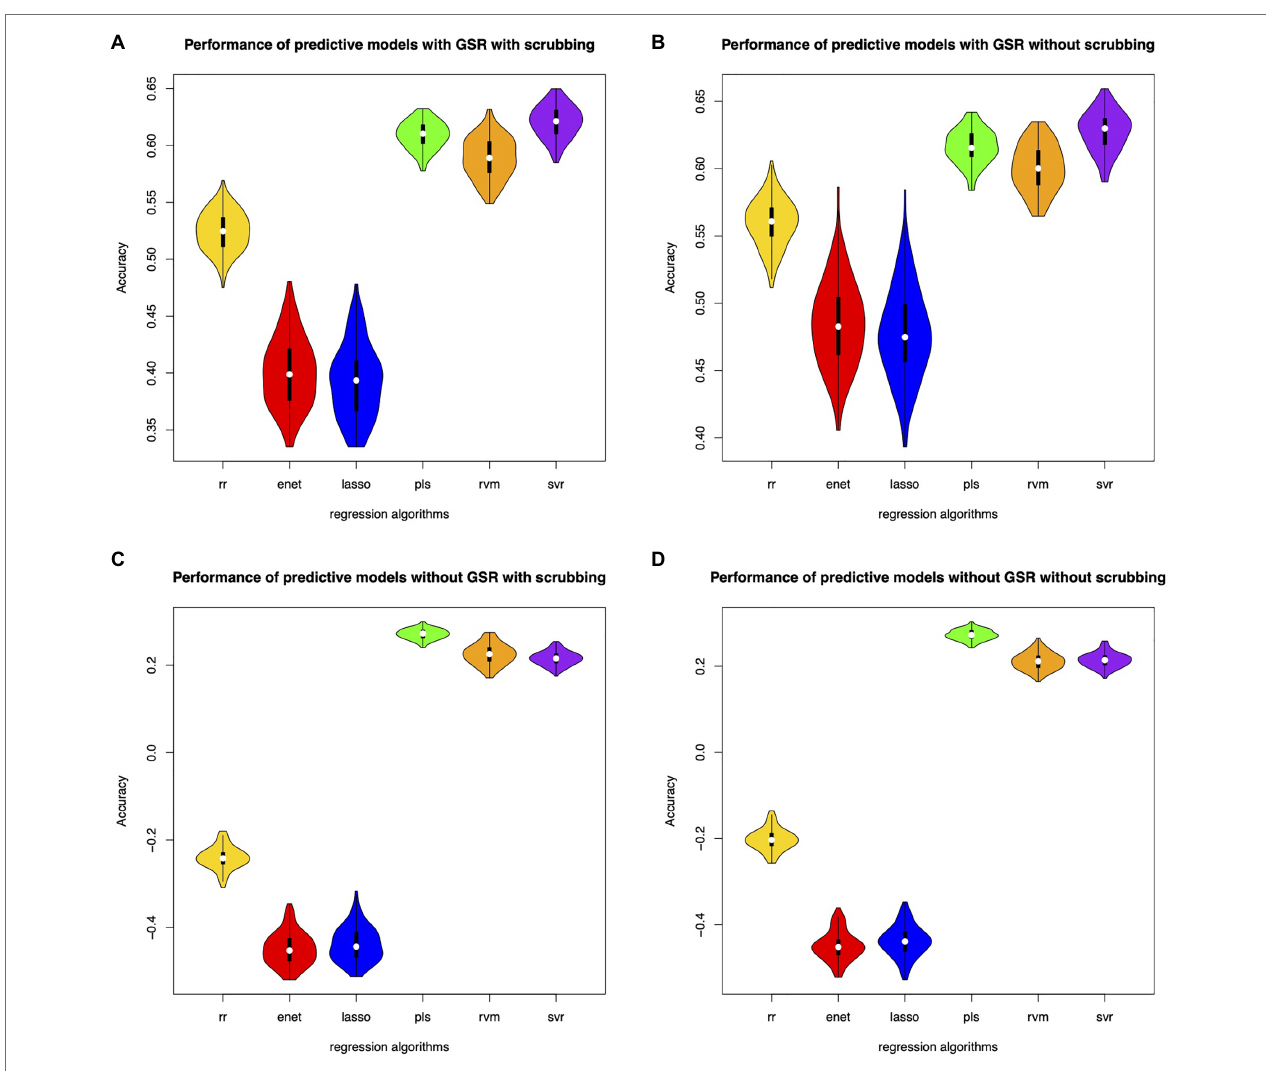
FIGURE 3 | Performance of the predictive models with classical feature selection ( p < 0.05 and r > 0). (A) denotes performance of the predictive models with GSR and scrubbing. (B) denotes performance of the predictive models with GSR and without scrubbing. (C) denotes performance of the predictive models without GSR and with scrubbing. (D) denotes performance of the predictive models without GSR and